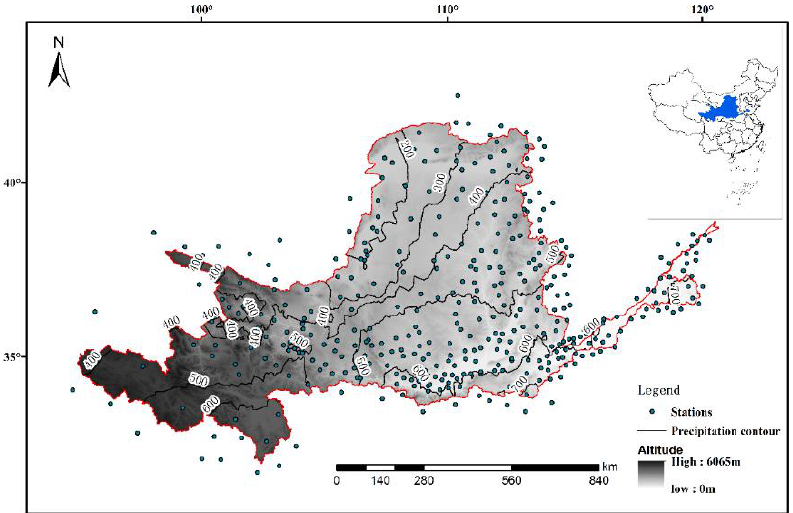
Figure 1. Locations of stations and contour of annual average rainfall in the YRB (data from CMDC [40]).